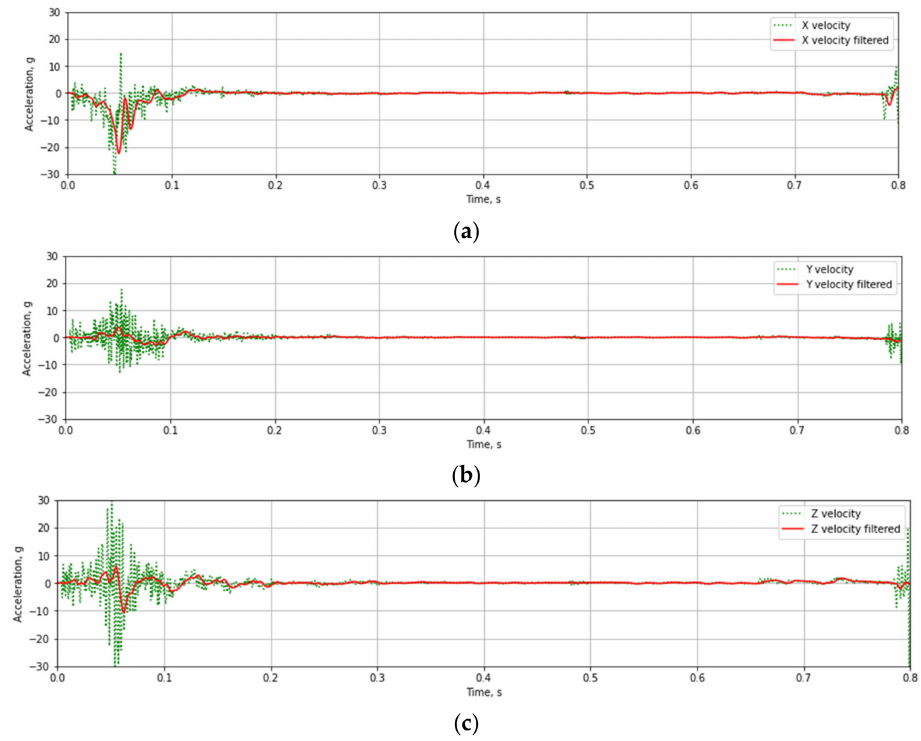
Figure 12. The result of a crash test with T03 mast at 35 km/h velocities. ( a ) velocity in OX-axis, ( b ) velocity in OY-axis, ( c ) velocity in OZ-axis.